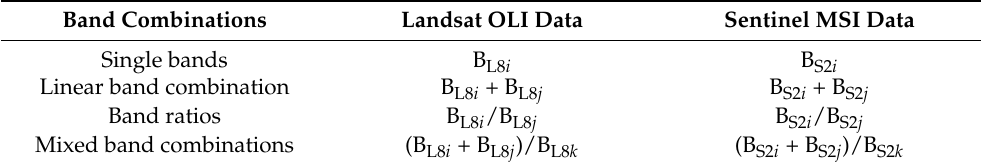
Table 3. The algorithms used for calculation of